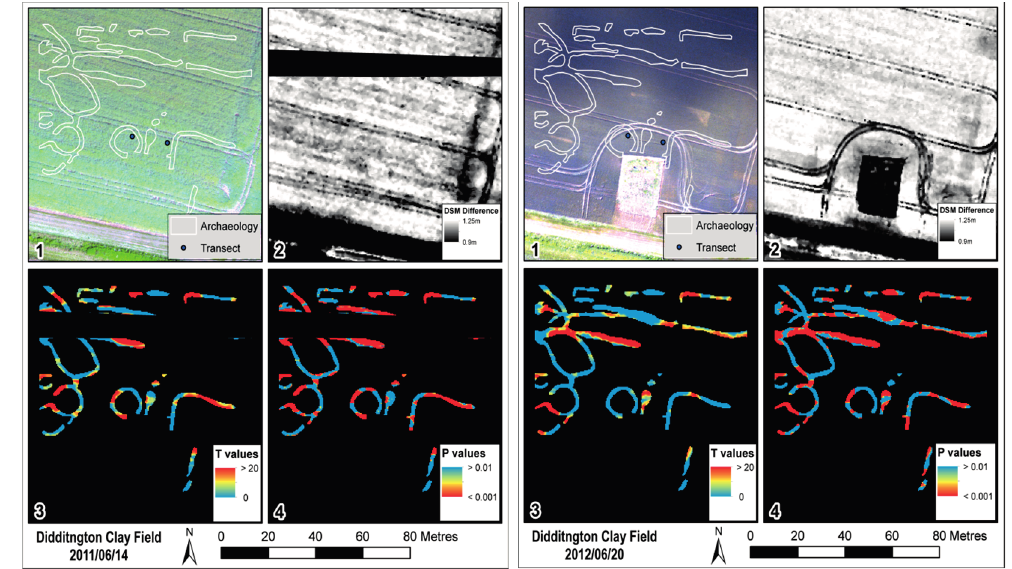
Figure 5. Multi-temporal airborne-LiDAR derived CHM for Diddington Clay field for Junes 2011 and 2012. (1) For comparison, aerial photography showing the locations of the archaeological features overlaid by those identified by magnetometer survey; (2) CHM data (referred to as difference in DSMs); (3) T -values indicating the strength of the localised contrast between the archaeological features and the background as exhibited by the CHM; (4) P -values indicating the localised statistical significance of the